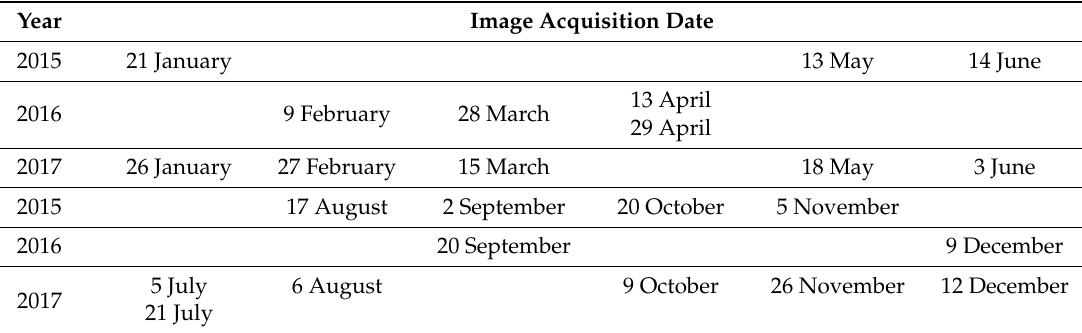
Table 1. Acquisition dates of Landsat 8